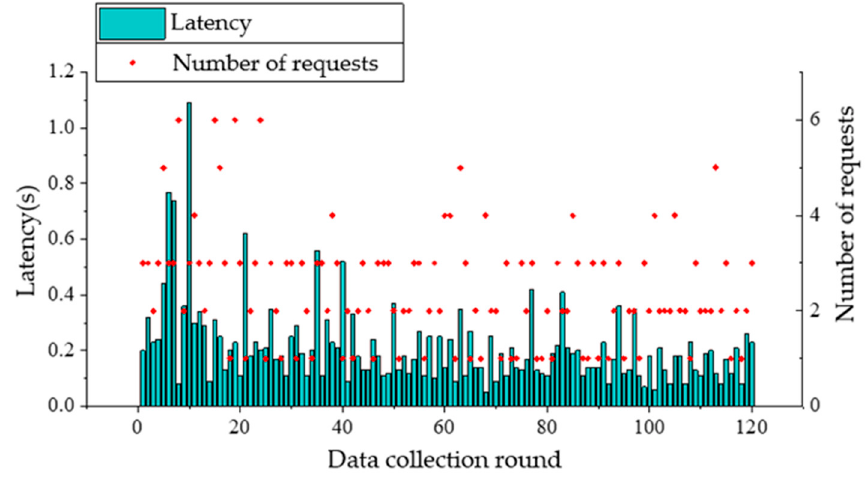
Figure 18. Communication latency of node B and the number of requests from UAV when flight altitude is 10 m. altitude is 10